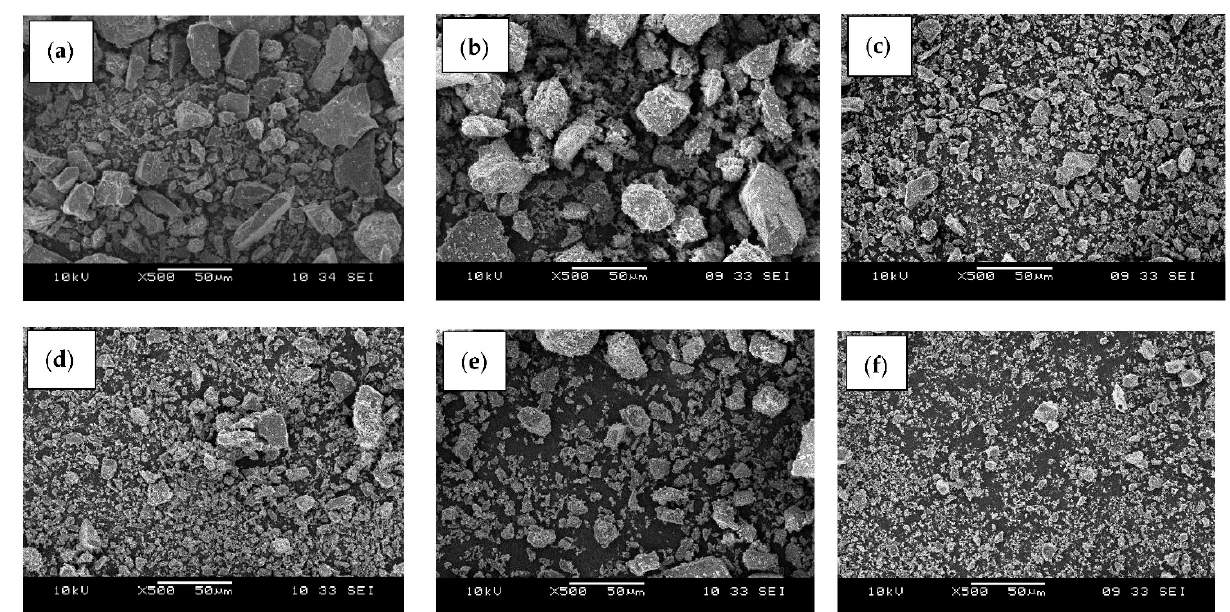
Figure 3. SEM images of dolomite that has been ball-milled for 500 rpm and ultrasonicated for 2 h with ( a ) 30% amplitude and 1 repetition (D 301X ), ( b ) 40% amplitude and 2 repetitions (D 402X ), ( c ) 40% amplitude and 3 repetitions (D 403X ), ( d ) 50% amplitude and 2 repetitions (D 502X ), ( e ) 50% amplitude and 3 repetitions (D 503X ), and ( f ) 50% amplitude and 10 repetitions (D 510X